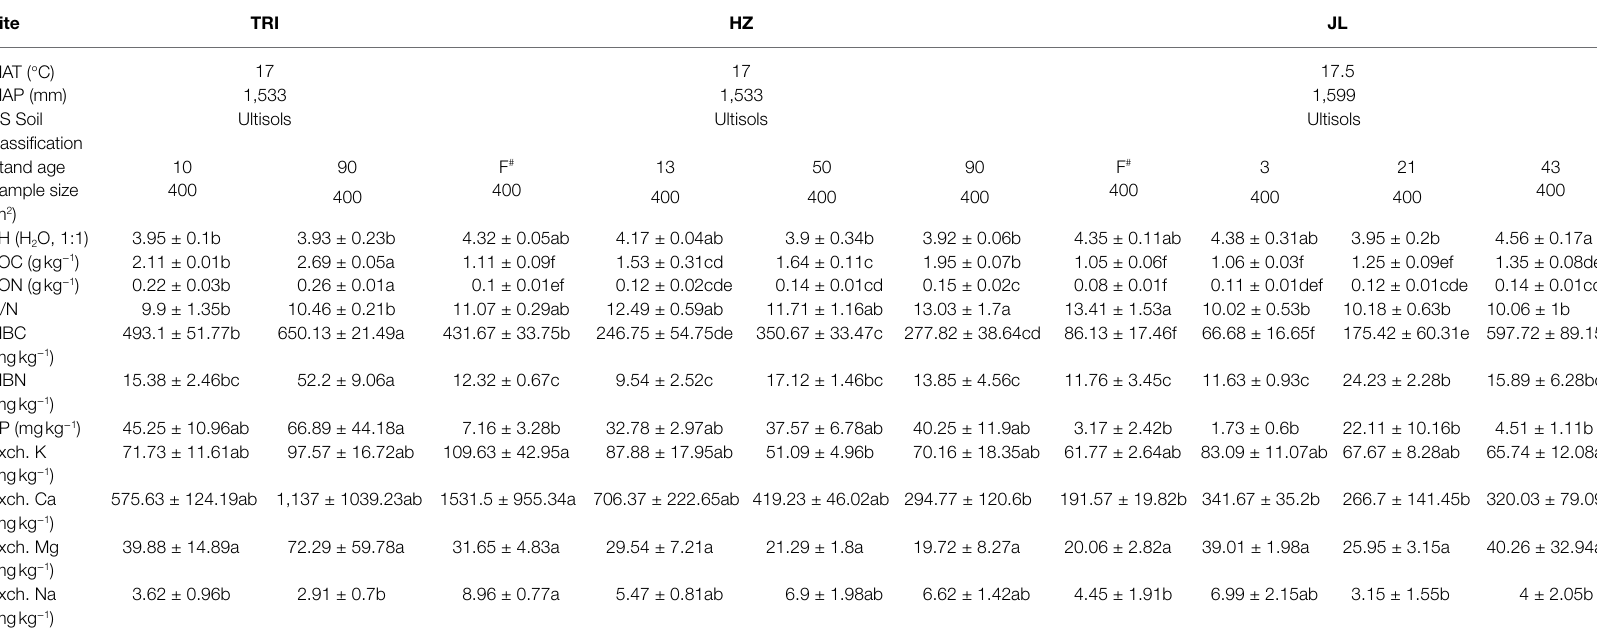
TABLE 1 | Selected information for the three tea plantations and soil physicochemical properties in tea plantations under different sites and stand ages.